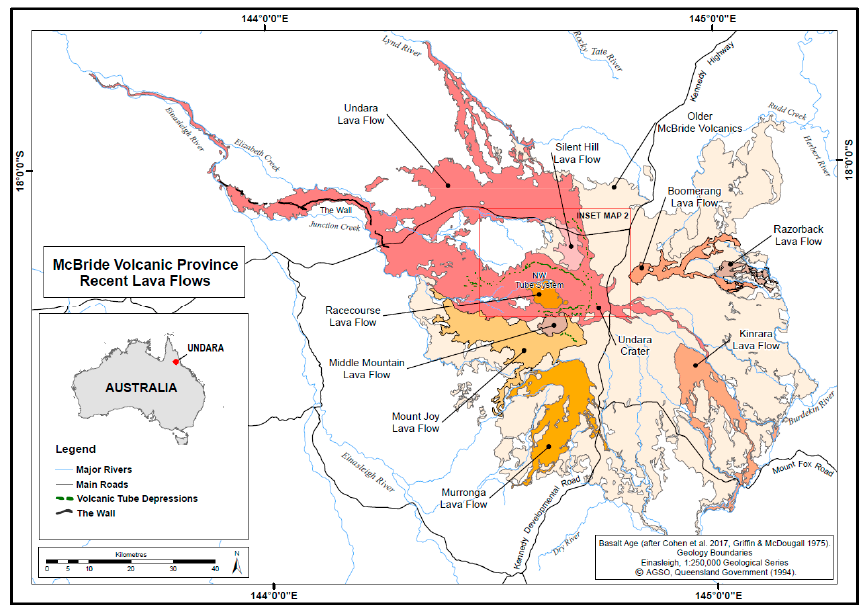
Figure 1. McBride Volcanic Province showing recent (<1 my) lava flows. Map adapted from Pearson [35] with permission from Chillagoe Caving Club. Geology boundaries from Queensland Government 1:250,000 Geological Series.